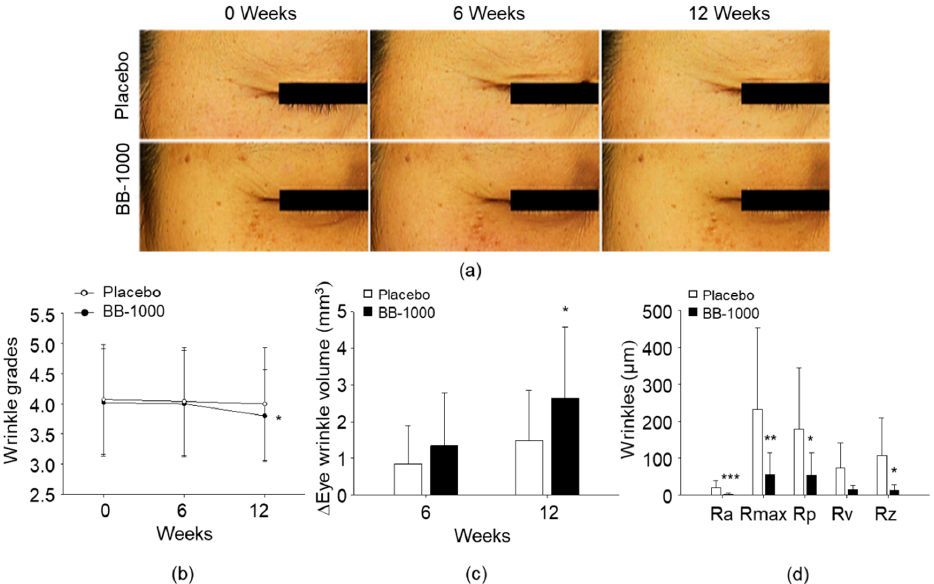
Figure 2. Effects of BB-1000 on eye wrinkle changes: ( a ) Representative photographs of participants with wrinkles after oral ingestion of placebo and BB-100 for 0, 6, and 12 weeks. ( b ) Photographic periorbital wrinkle grades at weeks 0, 6, and 12. ( c ) The effect of placebo and BB-1000 on skin wrinkle volume at 6 and 12 weeks. The eye wrinkle volume change is the difference in values after 6 and 12 weeks from the baseline (week 0). ( d ) Changes in skin wrinkle parameters after 12 weeks. Ra, average roughness; Rmax, maximum peak-to-valley; Rp, maximum peak height; Rv, maximum valley depth; Rz, maximum average roughness (Rz). Data are mean ± SD . * p < 0.05, ** p < 0.01, and *** p < 0.001 versus placebo.